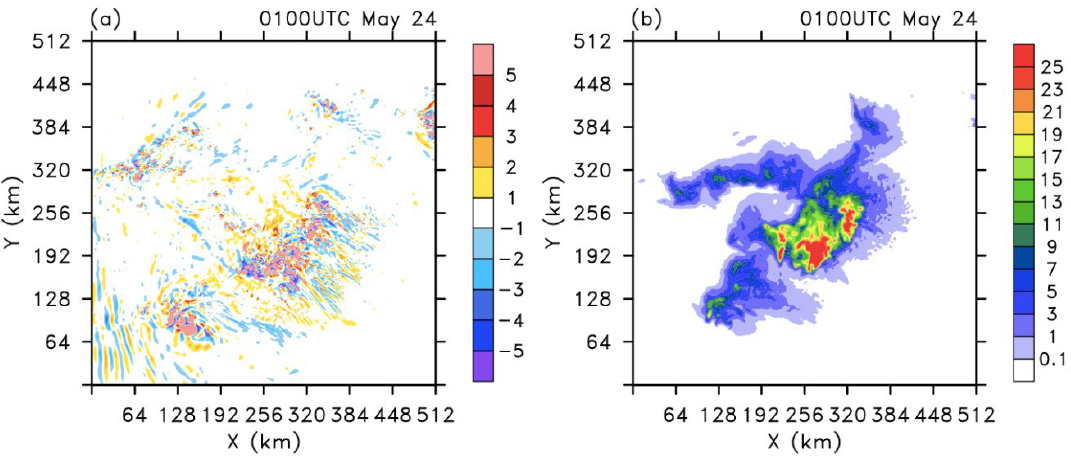
Figure 1. Snapshot of ( a ) vertical velocity (m/s) at 500 hPa and ( b ) surface precipitation (mm/h) at 0100 UTC 24 May. Precipitation is a 6-min averaged, the model output interval, converted to mm/h. Warm colors in ( a ) are for upward motion and cold colors are for downward motion.